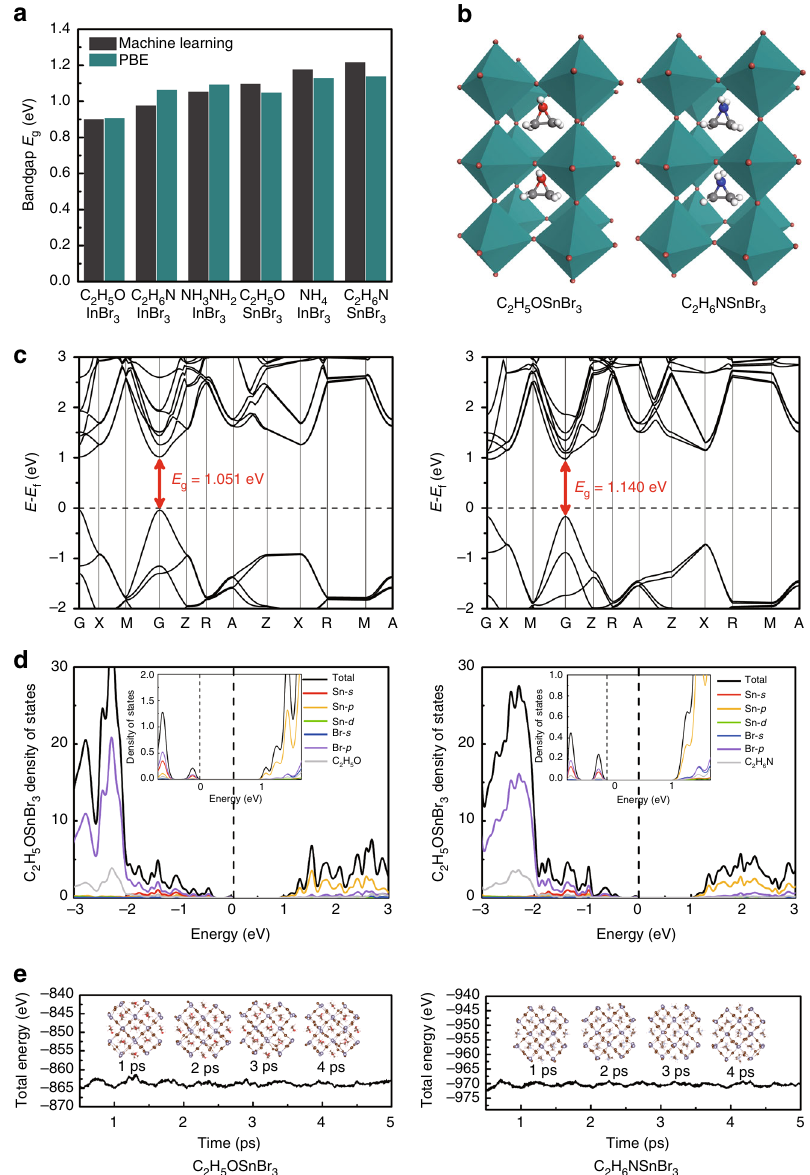
Fig. 5 Comparison with DFT calculations. a A comparison between ML-predicted and DFT-calculated results of six selected HOIPs. b Optimized structures, c band structures, d projected density of states (PDOS), e total energy during 5 ps AIMD simulations for C 2 H 5 OSnBr 3 and C 2 H 6 NSnBr 3 at 300 K. The subplots in d are the PDOS near the Fermi level